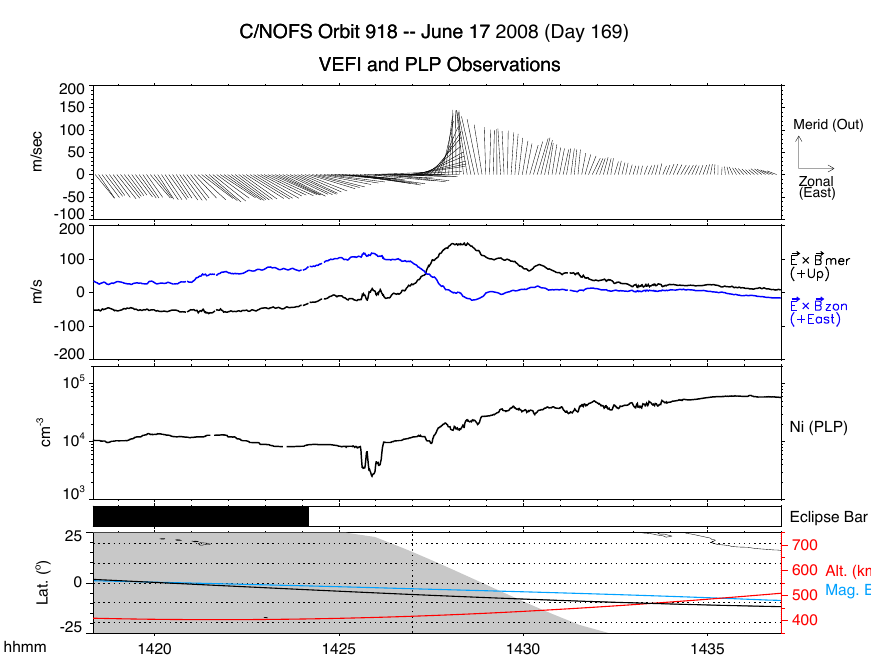
Figure 4. An enlargement of the data shown in Fig. 3 for Orbit 918. The top panel shows the E × B vector plasma drifts. The grey shading refers to the shadow on the